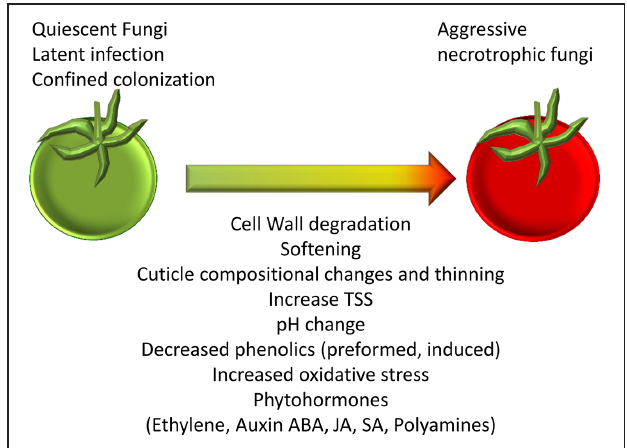
FIGURE 2 | Changes in the fruit that occur during ripening and senescence that regulate susceptibility. Morphological and biochemical changes taking place during the transition from unripe and tolerant to ripe and susceptible fruit. These changes could stimulate the release from quiescent/ latent or confined colonization to the aggressive colonization of the necrotrophic fungi in ripe